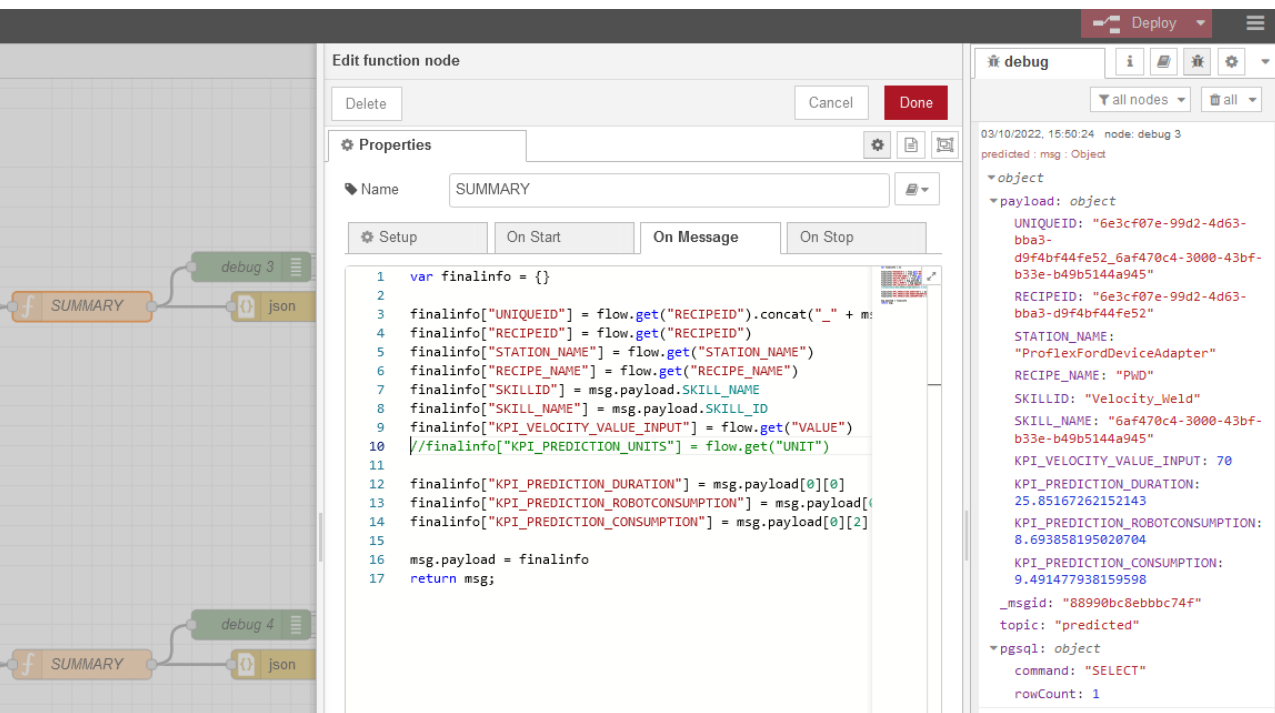
Figure 15. Function node “SUMMARY” used to retrieve data from all the Node-Red API process.